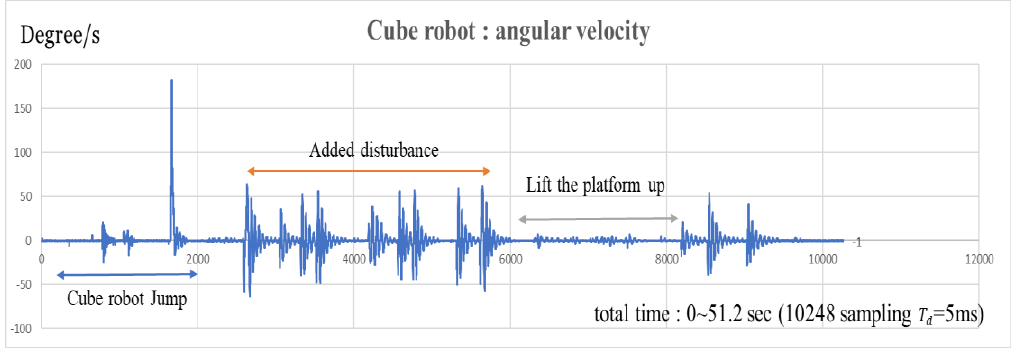
. θ P of the cube robot bouncing and balancing